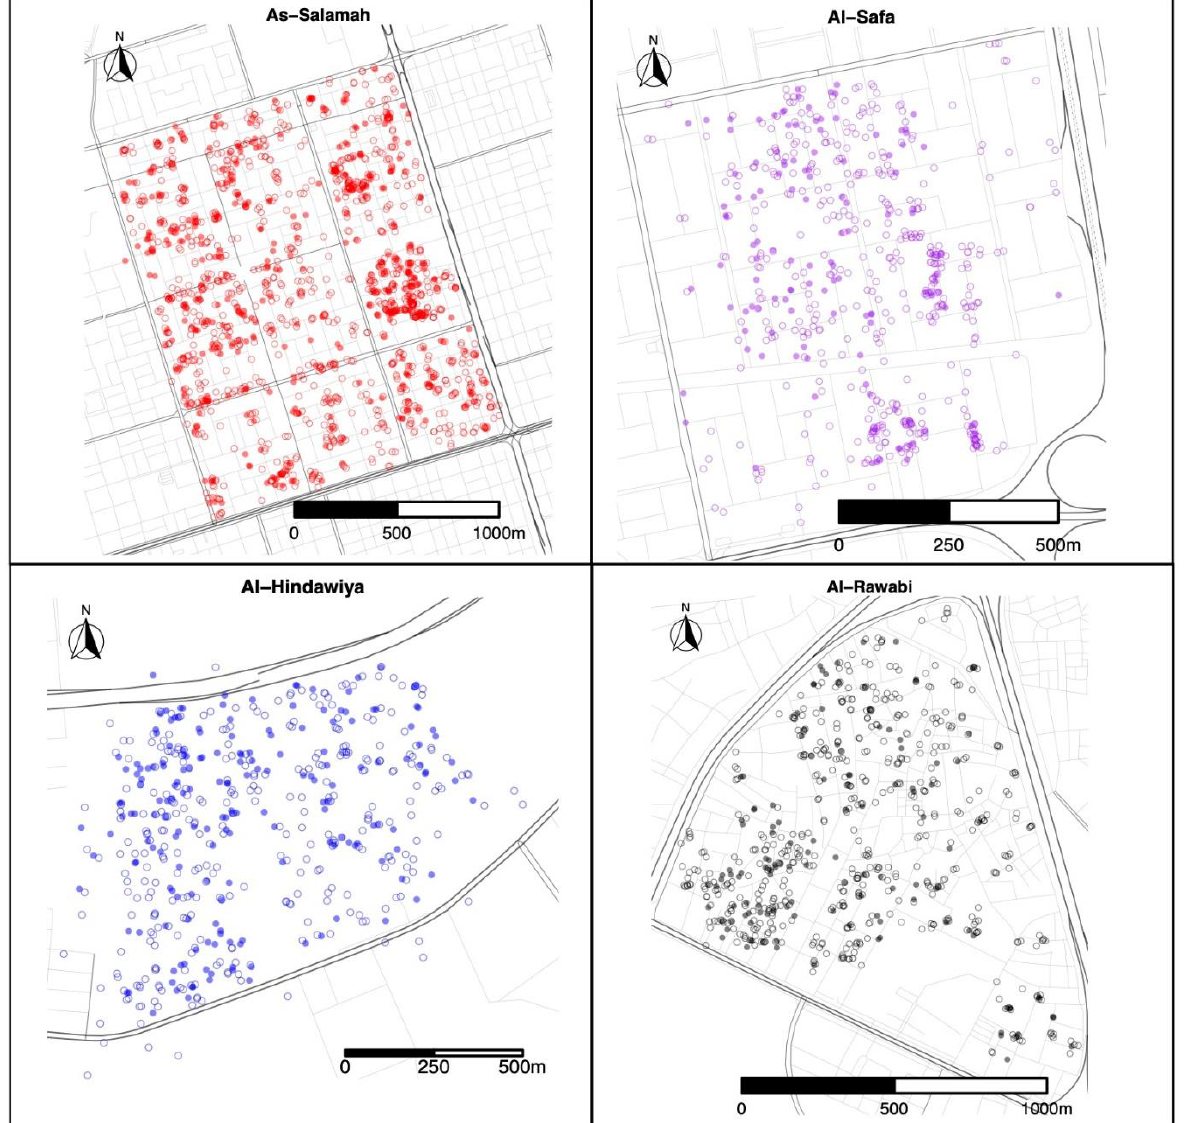
Figure 2. Spatial locations of felt collections over the four districts (As-Salamah, Al-Safa, Al- Hindawiya, and Al-Rawabi) in Jeddah, Saudi Arabia, across all data collection periods (from December 2020 to April 2022). Filled and non-filled circles show felts that were positive and negative for presence of Ae. aegypti mosquito eggs, respectively.